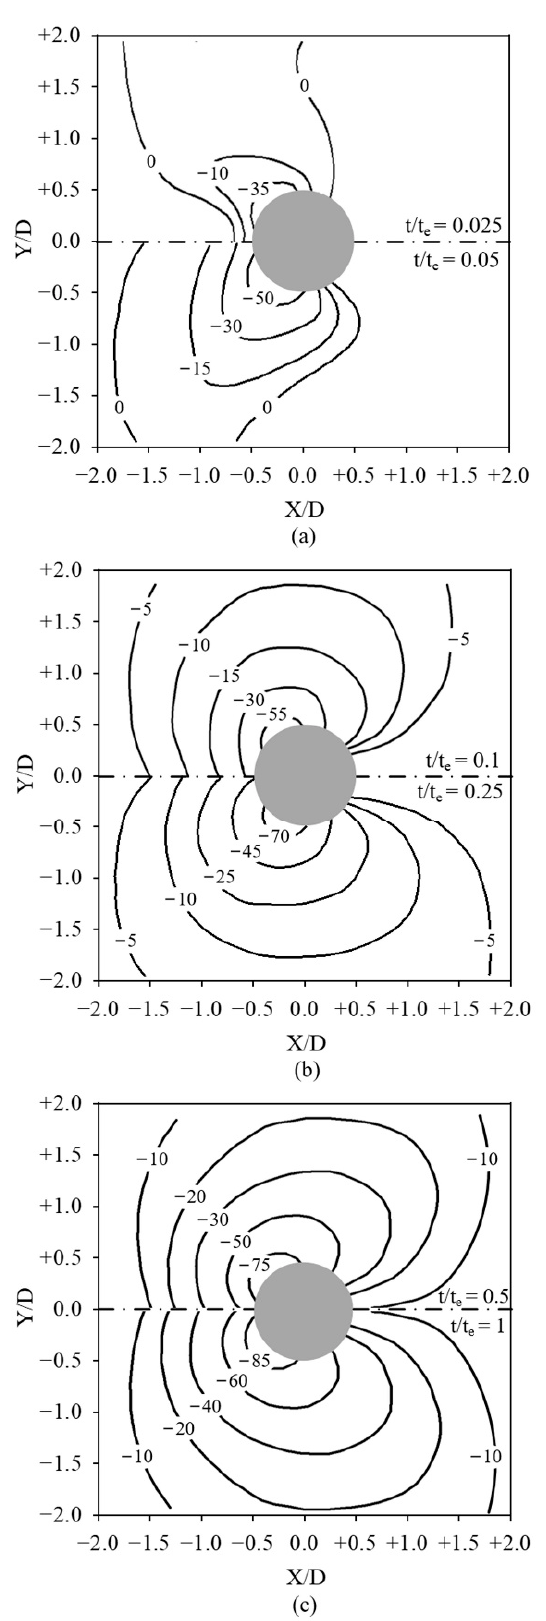
Figure 8. Evolution of scour pit elevation (mm): ( a ) t/t e = 0.025 and 0.05; ( b ) t/t e = 0.1 and 0.25; and ( c ) t/t e = 0.5 and 1.